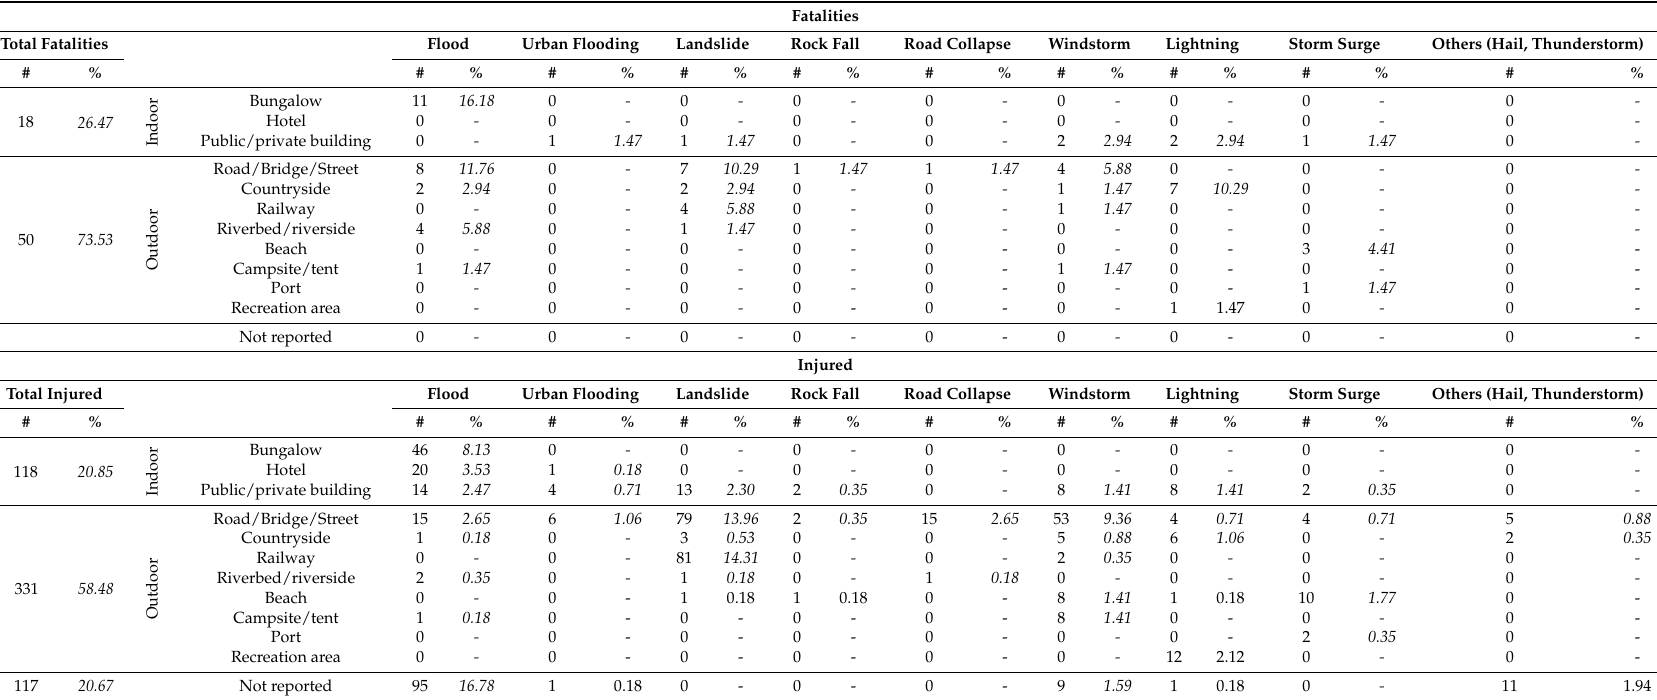
Table 7. Fatalities, injured and involved according to type of phenomenon and